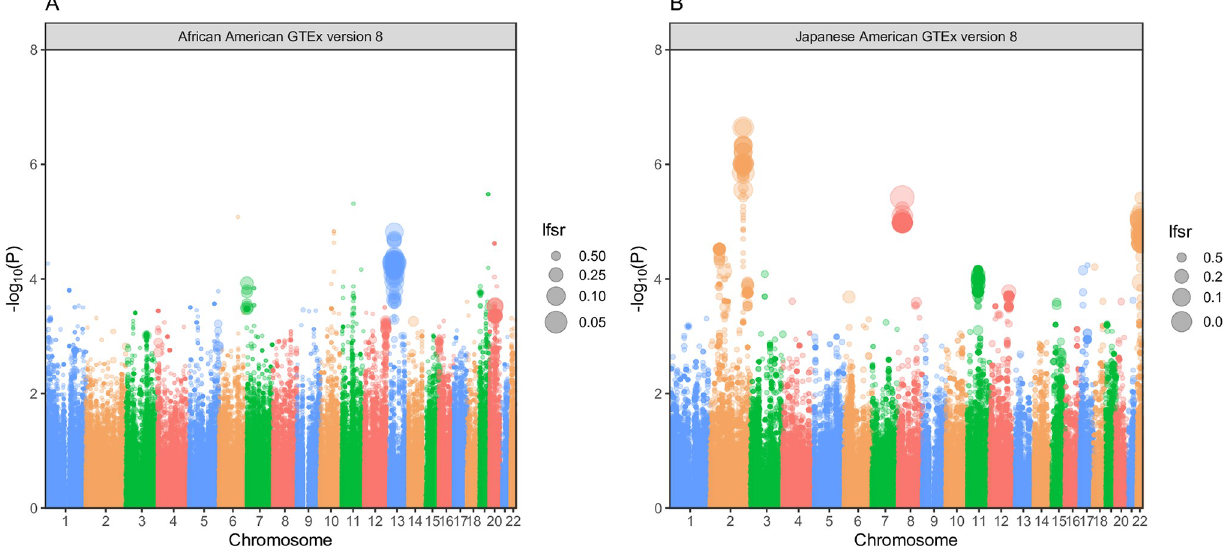
Fig 3. Prostate cancer PrediXcan results for GTEx predicted genes in African American and Japanese American populations. (A & B) are Manhattan plots of the PrediXcan results using GTEx version 8 mashr gene expression prediction models for the respective African American and Japanese American populations. Each point represents a gene-tissue test for association with prostate cancer via PrediXcan. The y-axis represents the − log 10 ( P ) of the gene- tissue test, and the x-axis plots chromosome number. The size of the dot is inversely proportional to its lfsr .